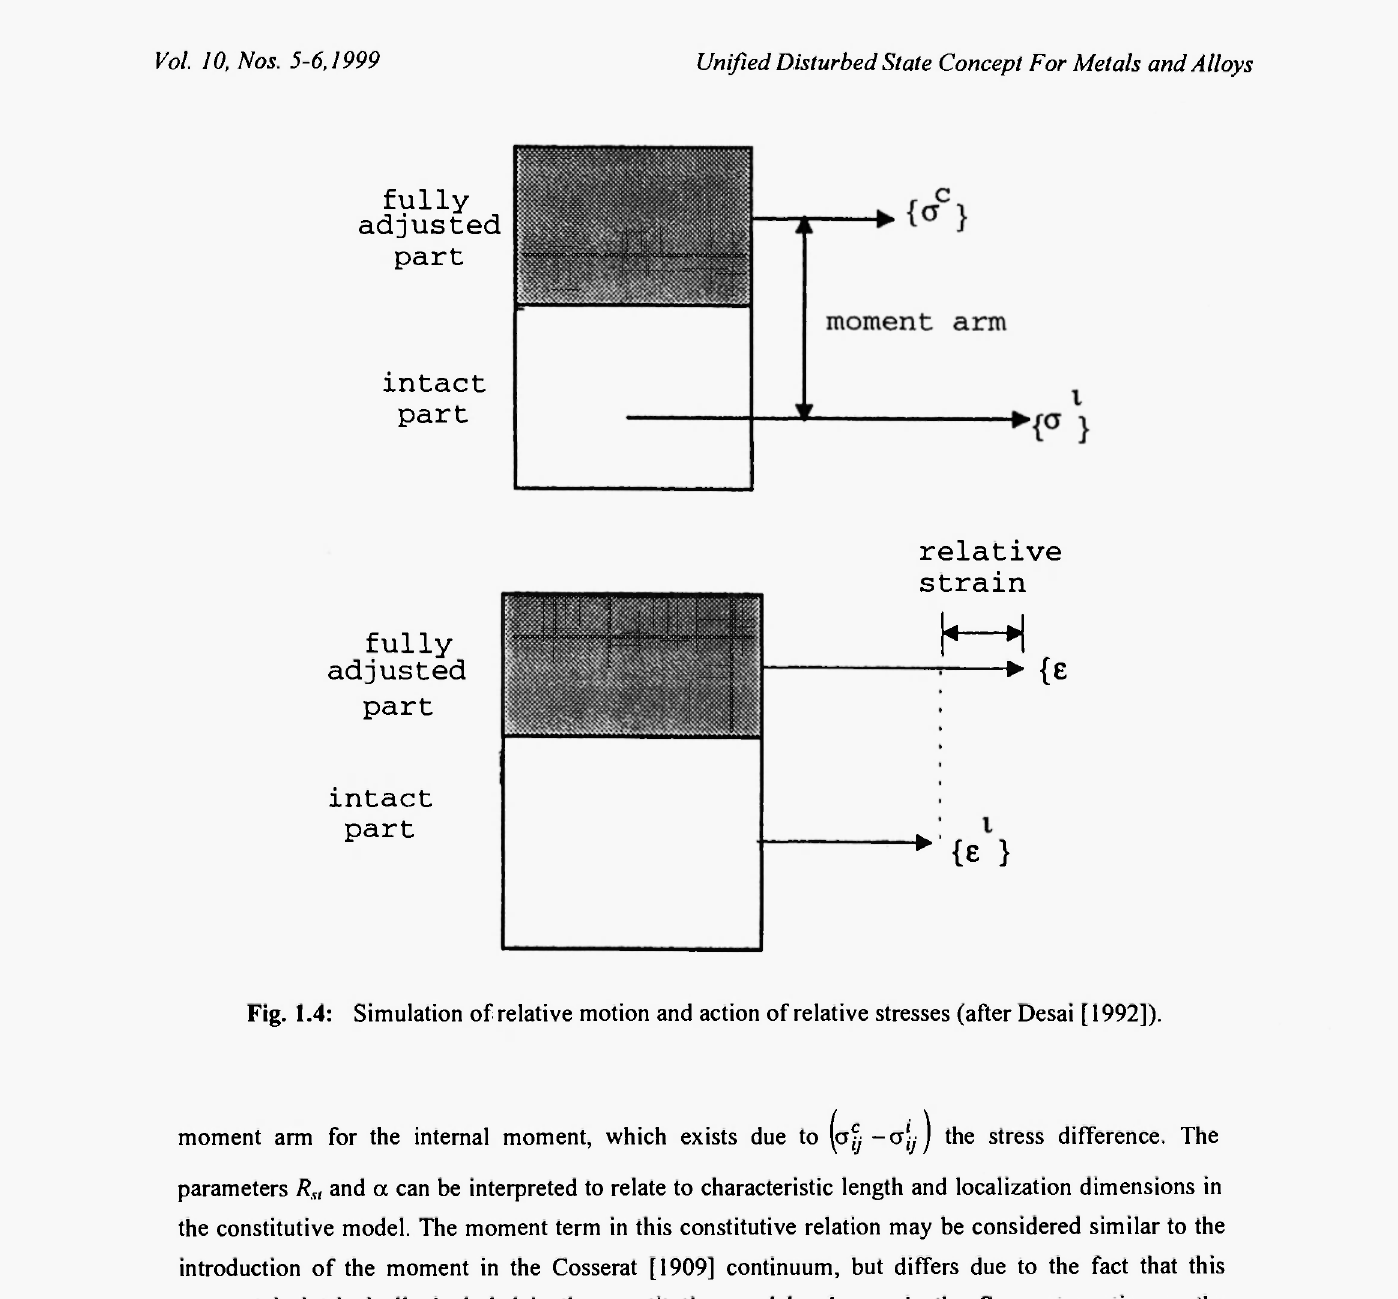
moment arm for the internal moment, which exists due to k - 4) the stress difference.